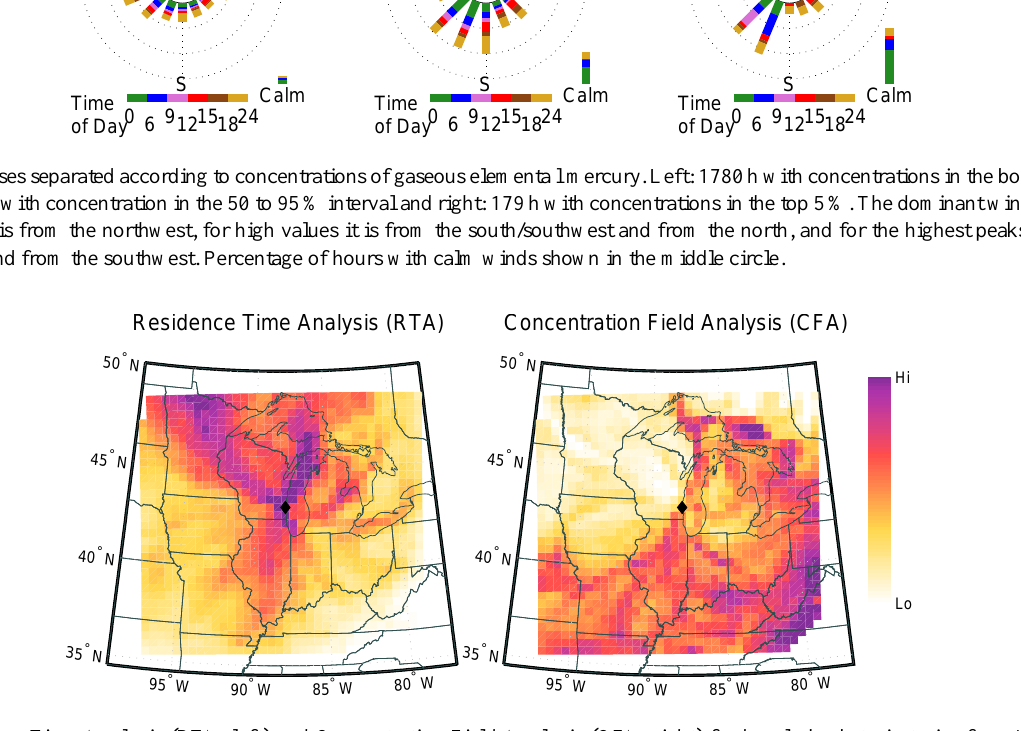
Fig. 7. Map of emissions from the inverse model using synthetic simulations from a location ( + ) 213 km northwest of the receptor site (diamond). Units are fraction of the synthetic release. Extent of the back- trajectory grid used for the inversion shown in pink. Areas with zero emissions shown in white. 33